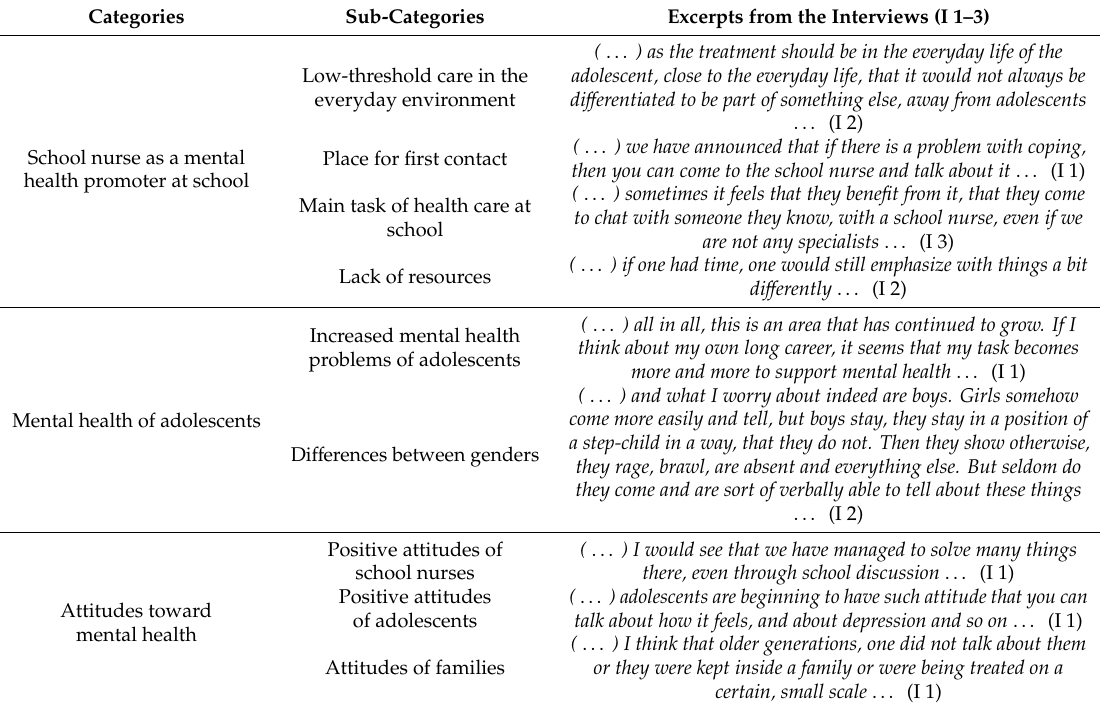
Table 1. Adolescents’ mental health promotion in health care at